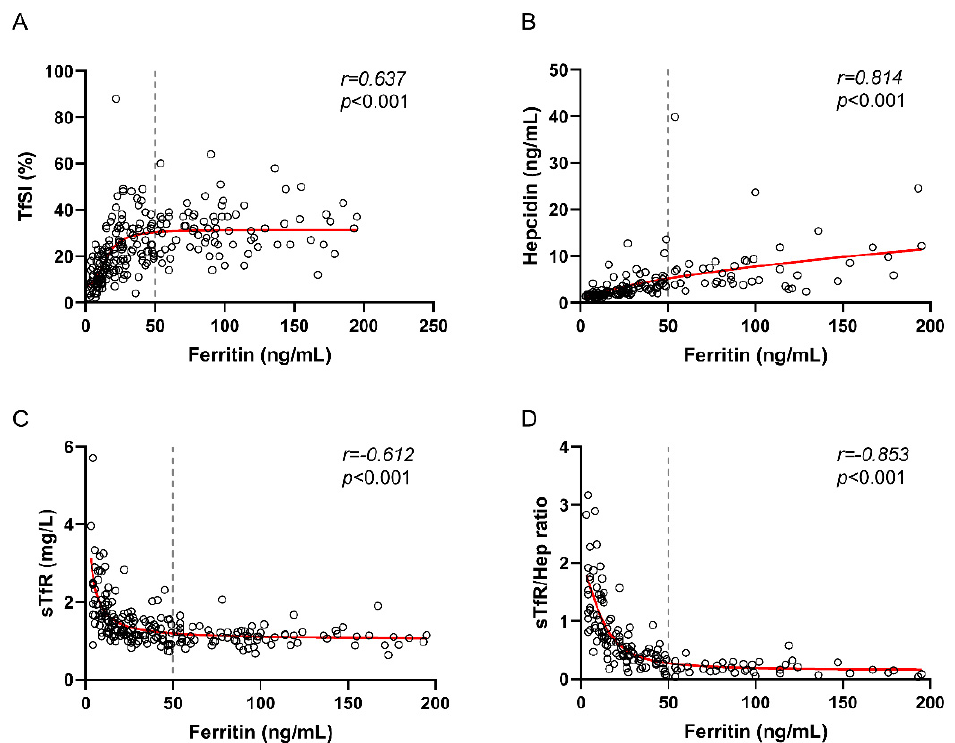
Figure 1. Correlations between early iron deficiency serum biomarkers and serum ferritin. Serum ferritin correlations with TfSI ( A ), Hepcidin ( B ), sTfR ( C ) and sTfR/Hep ratio ( D ) in all participants. Gray dashed line is the ferritin cut-off of 50 ng/mL. Abbreviations: TfSI, transferrin saturation index; sTfR, soluble transferrin receptor; Hep, hepcidin. Spearman’s correlation test was